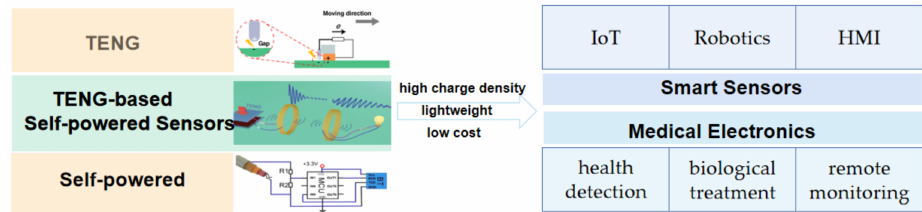
Figure 2. Schematic illustration of TENG-based Self-powered